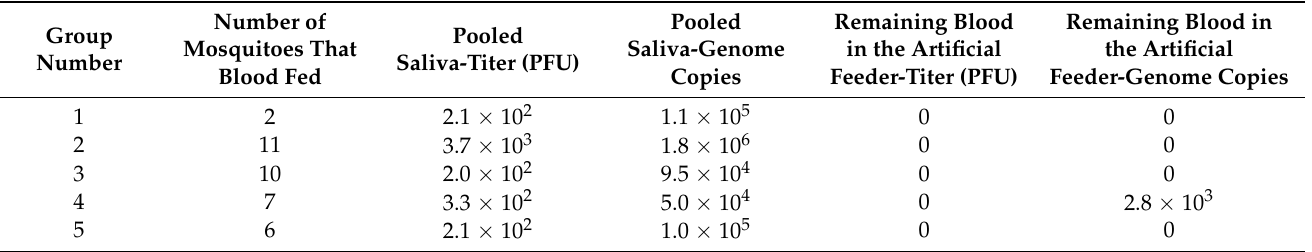
Table 6. Detection of CHIKV from forced salivations and from the blood remaining in the artificial feeders after infected mosquitoes blood fed on them.